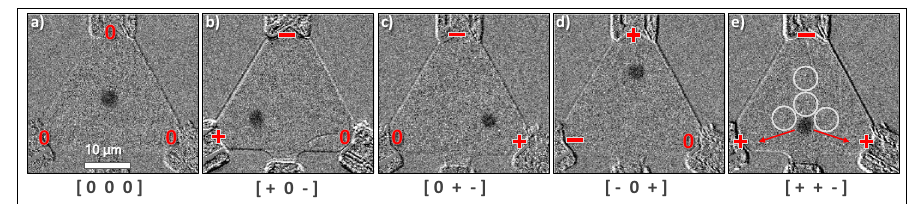
Fig. 2 | Skyrmion displacement. Subtracted Kerr-microscopy images of an equi- lateraltriangulardevicewithanedgelengthof36 µ m(tiptotip),eachwithasingle skyrmion (dark gray) in a the ground state without and b – e with appliedelectrical potentials. In brackets below are the input patterns of the respective state.